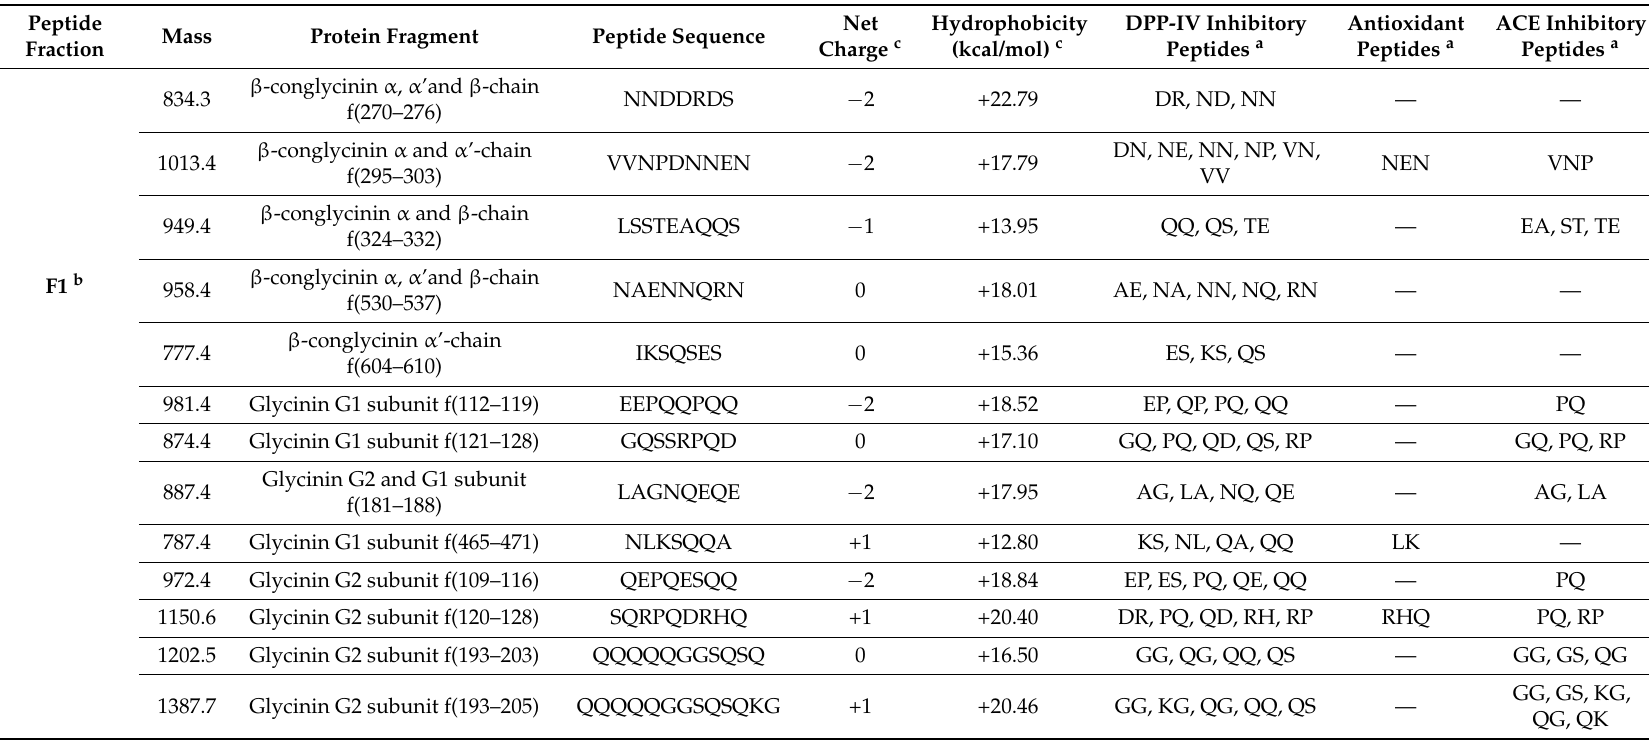
Table 2. Peptides identified by HPLC-MS/MS in the subfractions F1, F2, and F3 collected by RP-HPLC from 5–10 kDa fraction obtained from germinated soybean protein digest